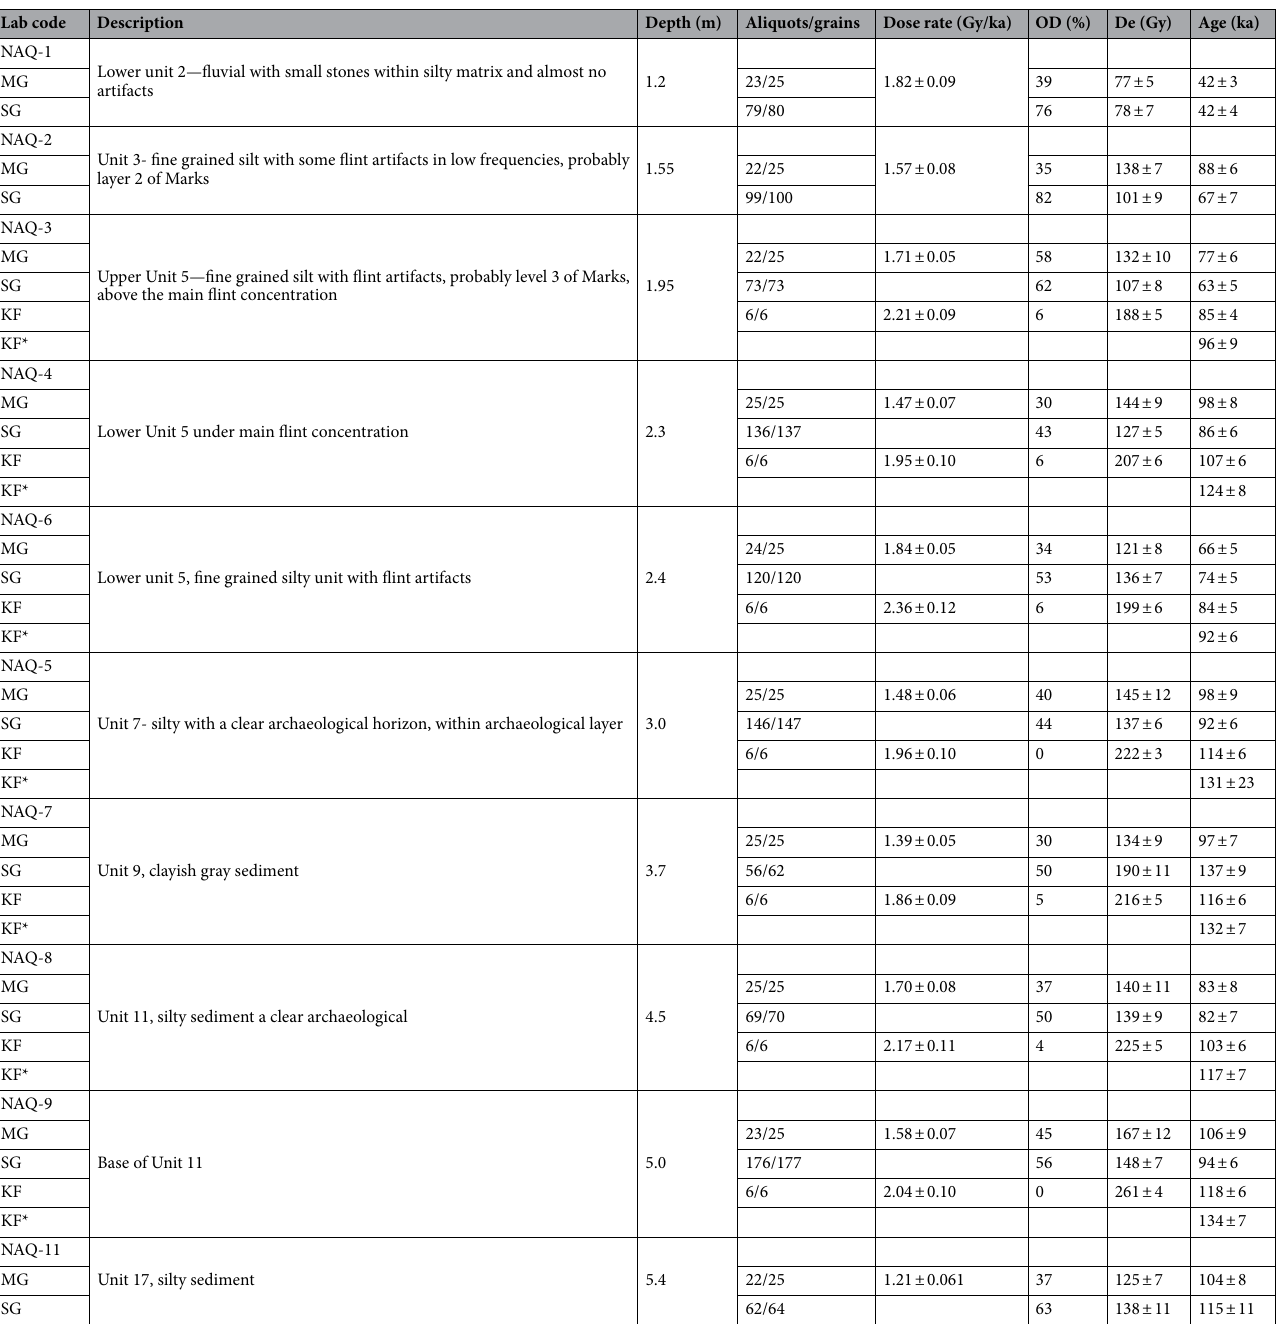
Table 1. Field and laboratory data for samples collected for luminescence dating. Samples arranged by burial depth. MG, multi-grain quartz; SG, micro-aliquot quartz; KF, multi-grain alkali feldspar. KF* are KF ages corrected for fading. Aliquots/grains is the number of aliquots or grains used for De calculations out of those accepted. OD—Overdispersion, the scatter within the sample beyond that expected from instrumental noise. Average and errors on the De values were calculated using the central age model 58 . Ages are in thousands of years. For details of dose rates and other parameters used for age calculations, see